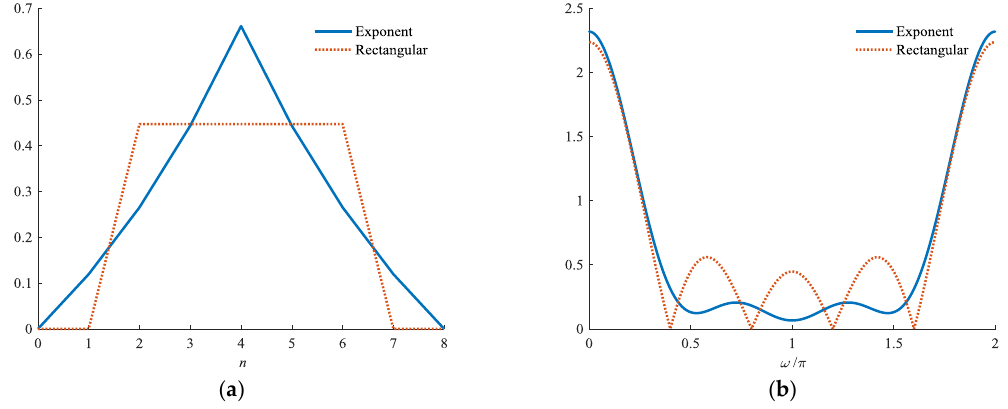
Figure 2. Chips with rectangular and exponent envelopes in: ( a ) time and ( b ) frequency domains, respectively.